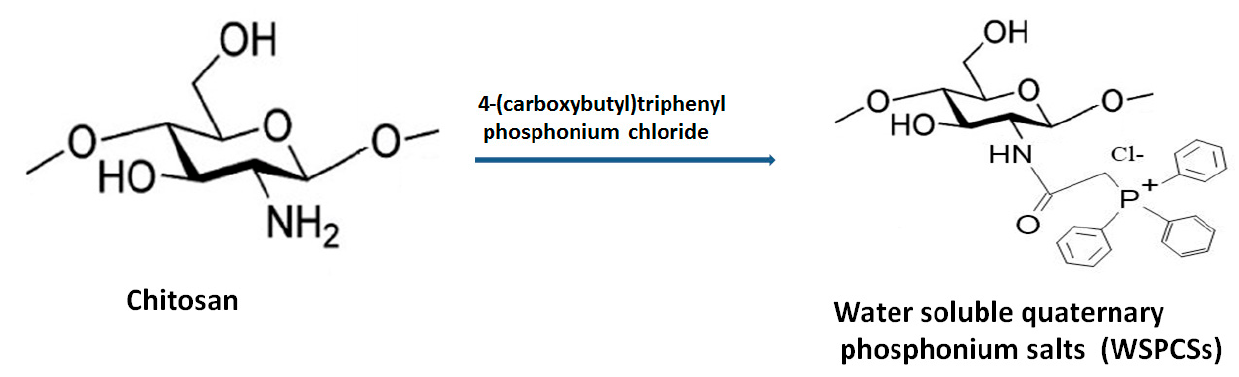
Figure 8. Synthesis of WSPCS from chitosan molecule.